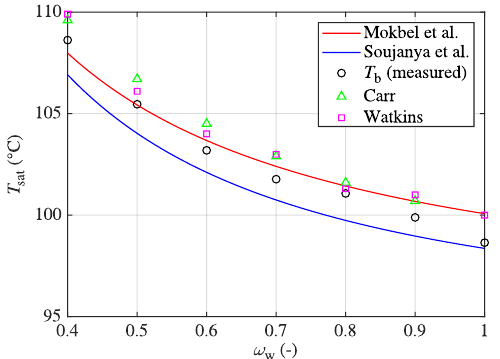
Figure 7. Measured and predicted bubble-point temperatures T b . Relative fractions of α / α ref are depicted in Figure 8 as functions of heat flux for all investigated concentrations. HTCs calculated with correlation (8) for pure water were used as reference values α ref . For comparison, ratios α / α ref calculated with correlation (8) are also shown as solid lines in Figure 8. One might observe that ratio α / α ref decreases with increasing heat flux which is common for various mixtures [48]. This decrease is more significant in the region of lower heat fluxes. For high heat fluxes, the ratio α / α ref is more flat and might be eventually considered as a constant. In addition, the effect of concentration on HTC is stronger for mixtures with higher water